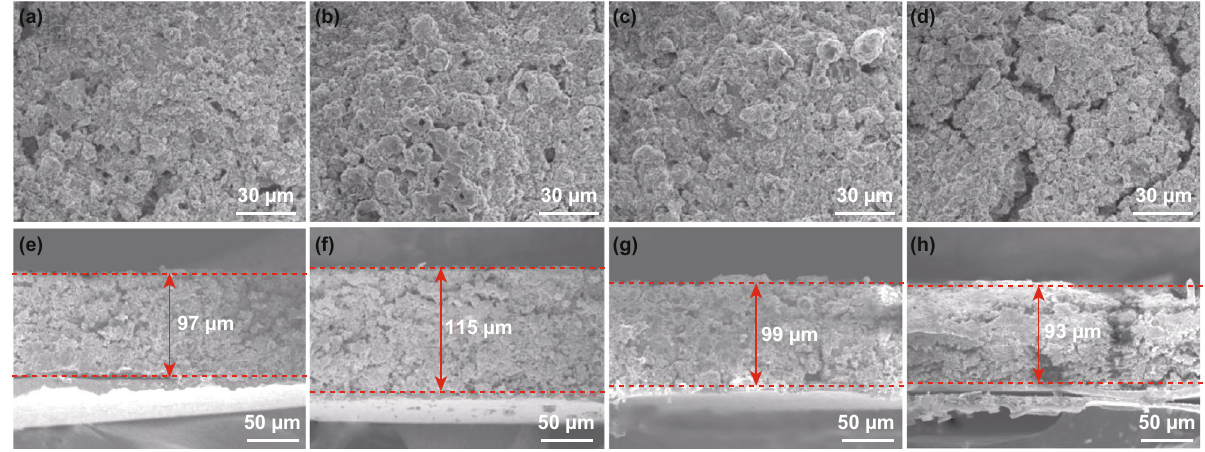
Fig. 2 Comparison of the sulfur electrode by SEM. Surface images of a fresh KB/S@Ti 3 C 2 T x electrode, b KB/S@Ti 3 C 2 T x electrode after 10 cycles, c fresh KB/S electrode, d KB/S electrode after 10 cycles. Cross-sectional images e before cycle and f after 10 cycles of the KB/S@ Ti 3 C 2 T x electrode, g fresh KB/S electrode and h after 10 cycles of the KB/S